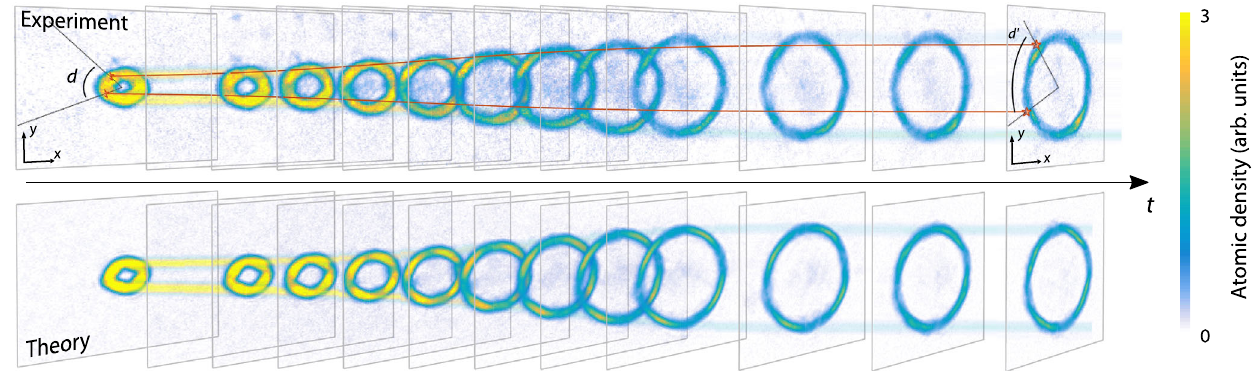
4 . 1 ð 3 Þ , where =R f i ¼